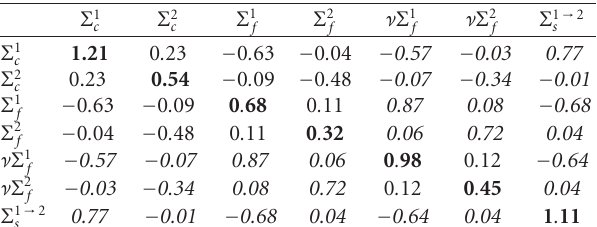
Table 2: Test covariance matrix [21]. Values in bold correspond to Case A, in bold and non-italic correspond to Case B, and the full covariance matrix correspond to Case